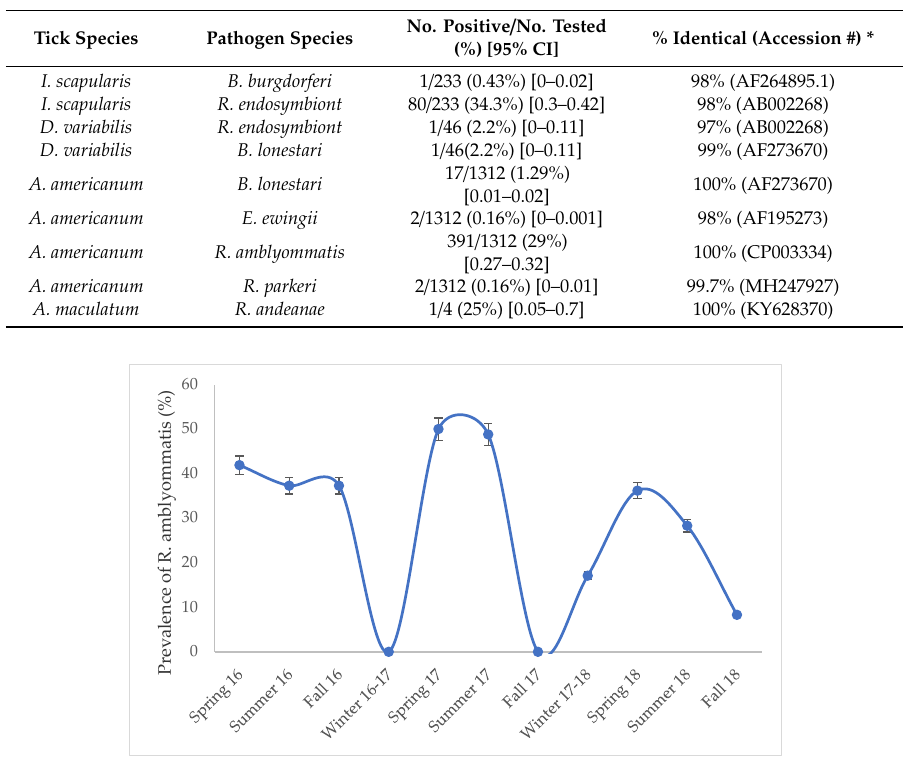
Figure 3. Prevalence ± 95% confidence interval (CI) of R. amblyommatis in all life stages of A. americanum over a three-year collection period. Amblyomma americanum were not collected in winter 1–17 and fall 17. Table 4. Pathogen prevalence of ticks collected from Spring 2016 through Fall 2018. * Most commonly reported BLAST result for each pathogen.